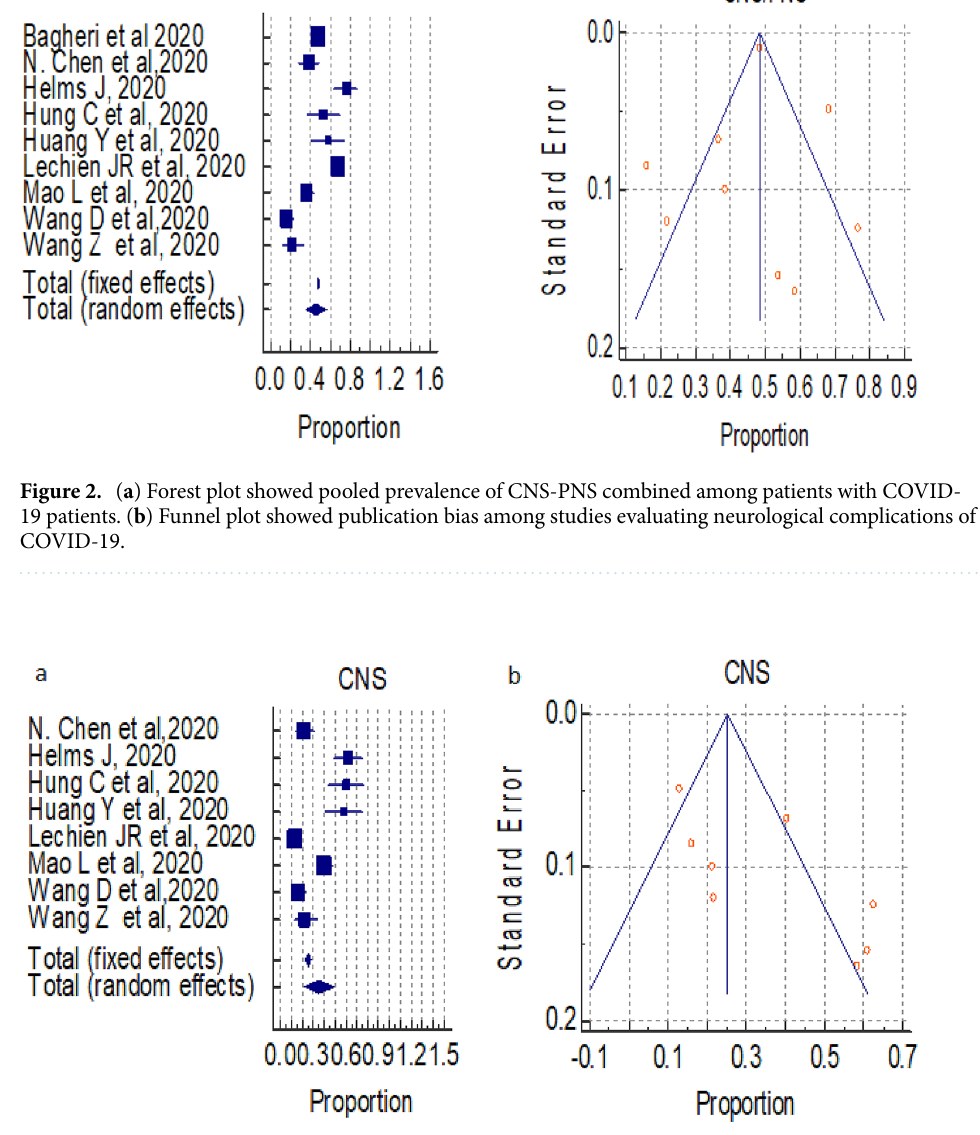
Figure 3. ( a ) Forest plot showed pooled prevalence of CNS complication among patients with COVID-19. ( b ) Funnel plot showed publication bias among studies evaluating neurological complications of